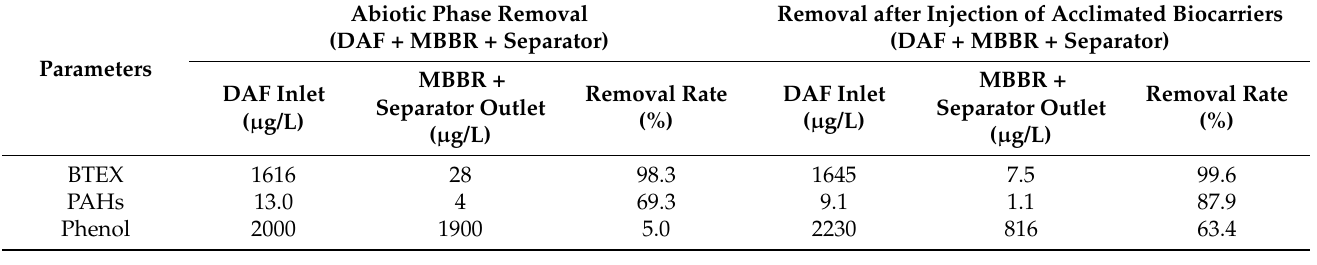
Table 3. Role of acclimated biocarriers on BTEX, PAHs and phenol removal rate.